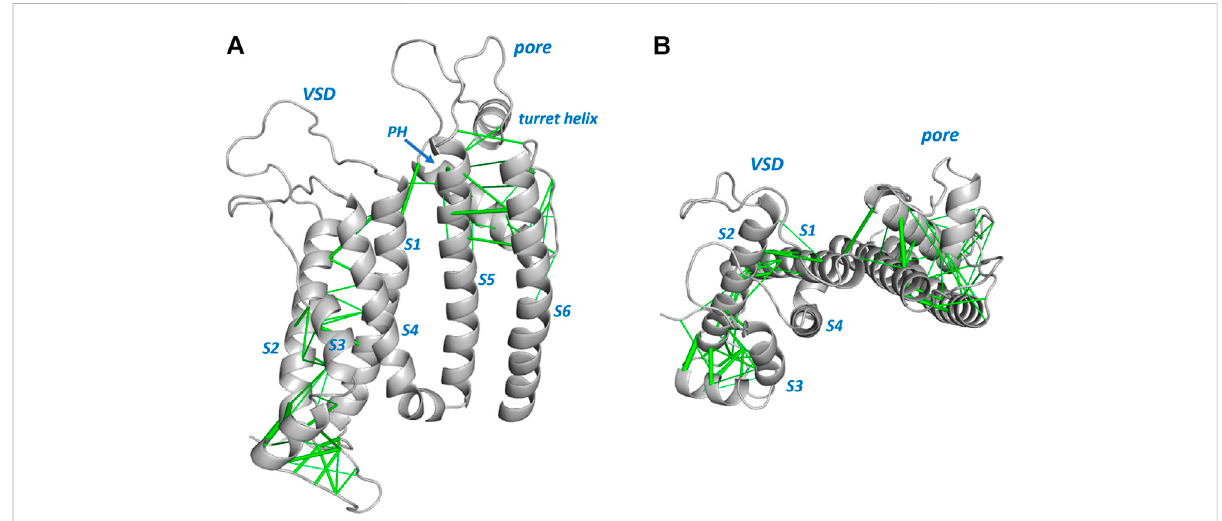
FIGURE 2 Evolutionarily coupled amino acids in the hERG channel membrane domain. A single subunit from PDB:5VA2 (Wang and Mackinnon, 2017) is shown. Sequence involving some missing atom density in extracellular loops is modeled into the structure shown. Evolutionarily coupled pairs of aminoacidsarerepresentedbygreenlinesconnectingC α atoms(lineweightrepresentsprobabilityofECpair),andtheseareshown (A) fromtheside and (B) looking down from the extracellular membrane surface. The latter view illustrates minimal EC interactions between the mobile S4 helix and the “ scaffold ” parts of the VSD involving S1-S3 (Palovcak et al., 2014). PH: Pore